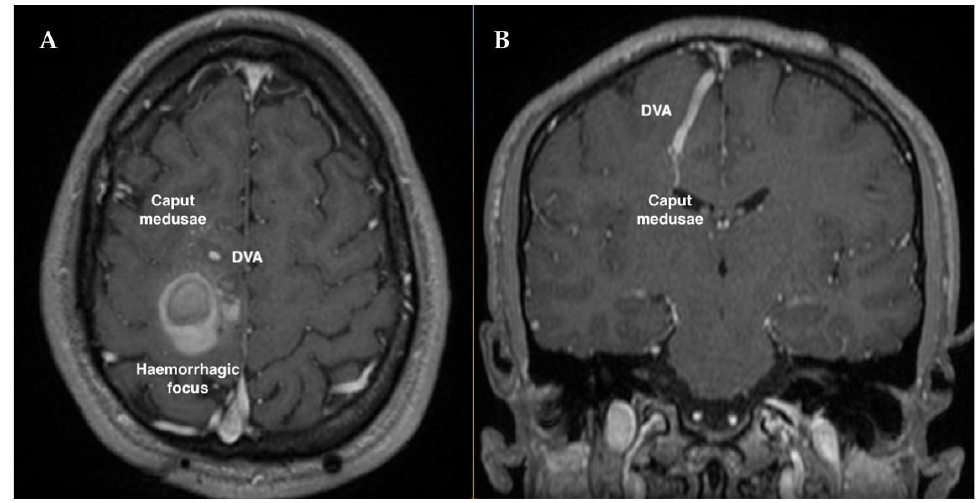
Figure 1. First preoperative T1 contrast-enhanced MRI showing a hemorrhagic cavernoma in the vicinity of a voluminous DVA, with its typical caput medusae sign, in the right frontal lobe: ( A ) axial view; ( B ) coronal view.